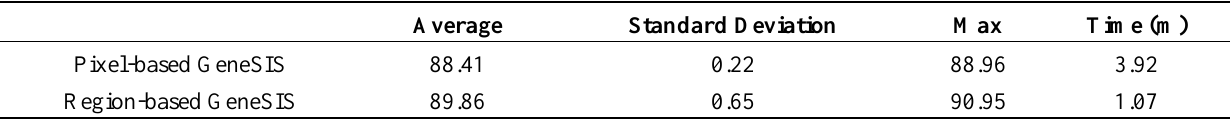
Figure 10. University of Pavia image: ( a ) three-band false color composite, ( b ) reference sites, ( c ) watershed segmentation map, ( d ) initial segmentation map after CC labeling, ( e ) segmentation map after GeneSIS, and ( f ) classification map after FMV-fusion. Table 6. Average OA, standard deviation of OA, maximum OA, and execution time for the two GeneSIS versions in University of Pavia